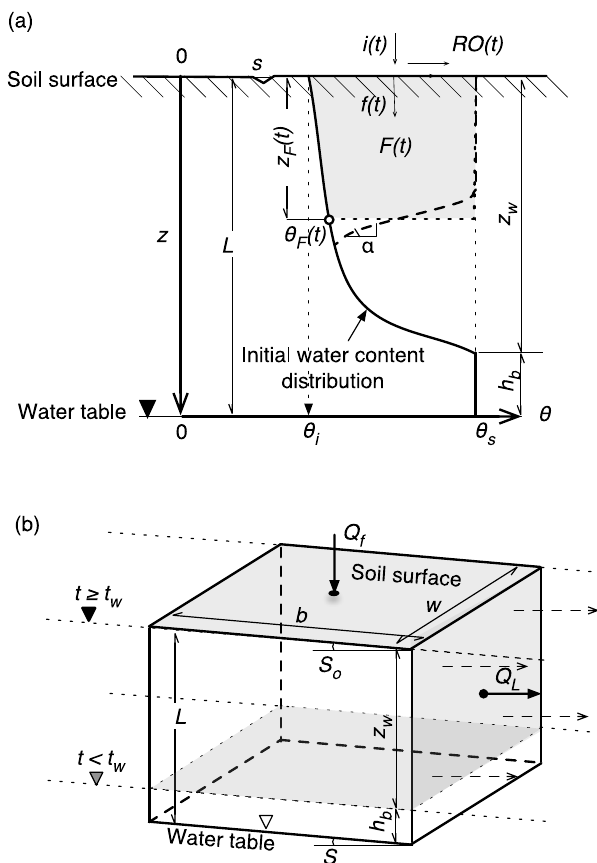
Figure 1. Conceptual depiction of infiltration and soil water redis- tribution for soils with shallow water table for (a) time before wet- ting front reaches the water table and (b) time after the wetting front reaches the water table ( t ≥ t w ) , where surface infiltration flow ( Q f ) is limited by lateral Boussinesq subsurface flow ( Q L ) . See explana- tion of symbols in the